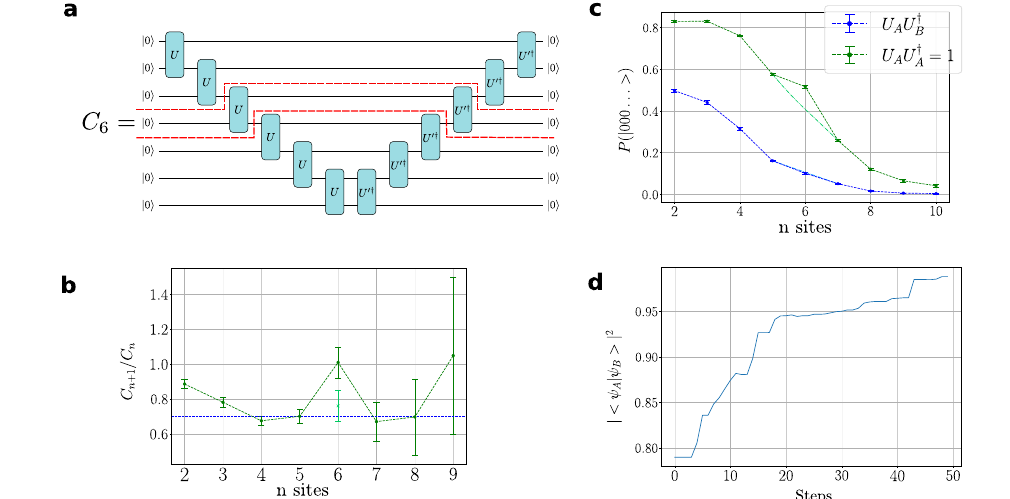
Fig. 3 | Calculating state overlaps. a The overlap of two translationally invariant states parametrised by U and U 0 is given by lim C n ! λ n , where λ is the principle n !1 eigenvalueofthetransfermatrixdelimitedbythereddottedline. C for depolarisation errors, we divide by the Loschmidt echo obtained by evaluating thecircuitat U 0 = U . b Overlaps C n ( U A , U B )andLoschmidtecho C n ( U A , U A )evaluated